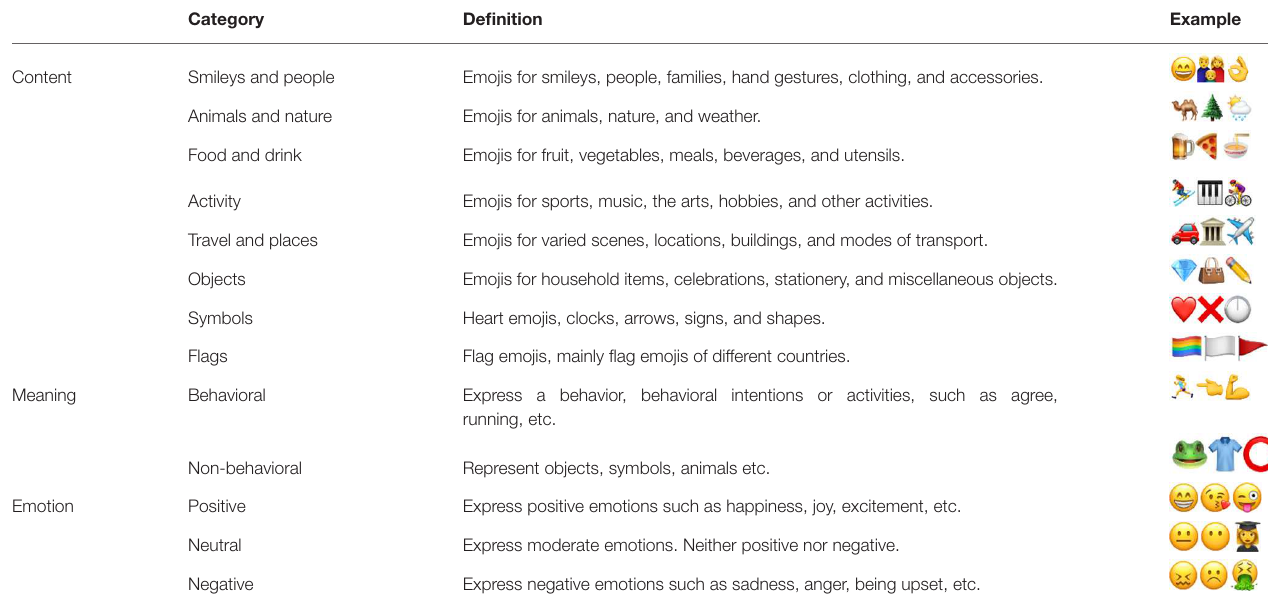
TABLE 6 | Categories, semantic, and emotional functions of emoji. Category Definition Example